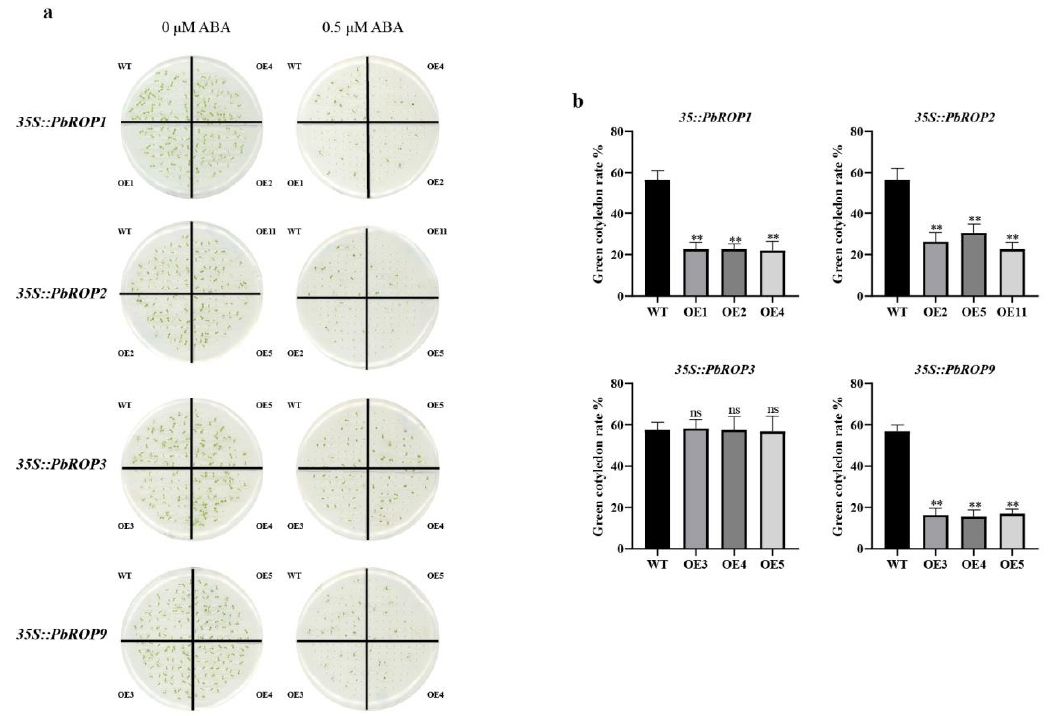
Figure 9. PbROP1, 2, 3, and 9 overexpressing transgenic Arabidopsis seedlings have different sensitivity to ABA. ( a ) The phenotype of the 35S::PbROPs Arabidopsis seedlings grown on plates without or with 0.5 µM ABA; ( b ) percentage of seedlings with green cotyledons of the 35S::PbROPs transgenic Arabidopsis seedlings grown on plates without or with 0.5 µM of ABA. Seeds of homozygous transgenic Arabidopsis were surface-sterilized and germinated on ½ MS with or without 0.5 µM ABA. After 10 days, the phenotype was observed and the percentage of seedlings with green cotyledons was calculated. The values represent the means ±SE (n = 3). The data were analyzed via the Student ’ s t -test using GraphPad Prism (8.0.2, Harvey Motulsky, California, USA) software. ** indicate significant differences in comparison with WT at p < 0.01. ns, no significant difference.